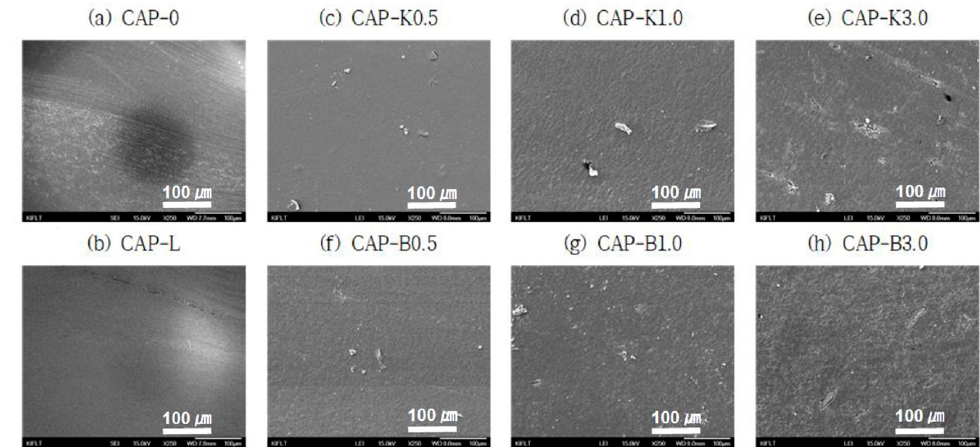
Figure 14. SEM images showing dispersibility of composites after adding biofillers ( × 250 magnifica- tion): ( a ) CAP-0; ( b ) CAP-L; ( c ) CAP-K0.5; ( d ) CAP-K1.0; ( e ) CAP-K3.0; ( f ) CAP-B0.5; ( g ) CAP-B1.0; and ( h )